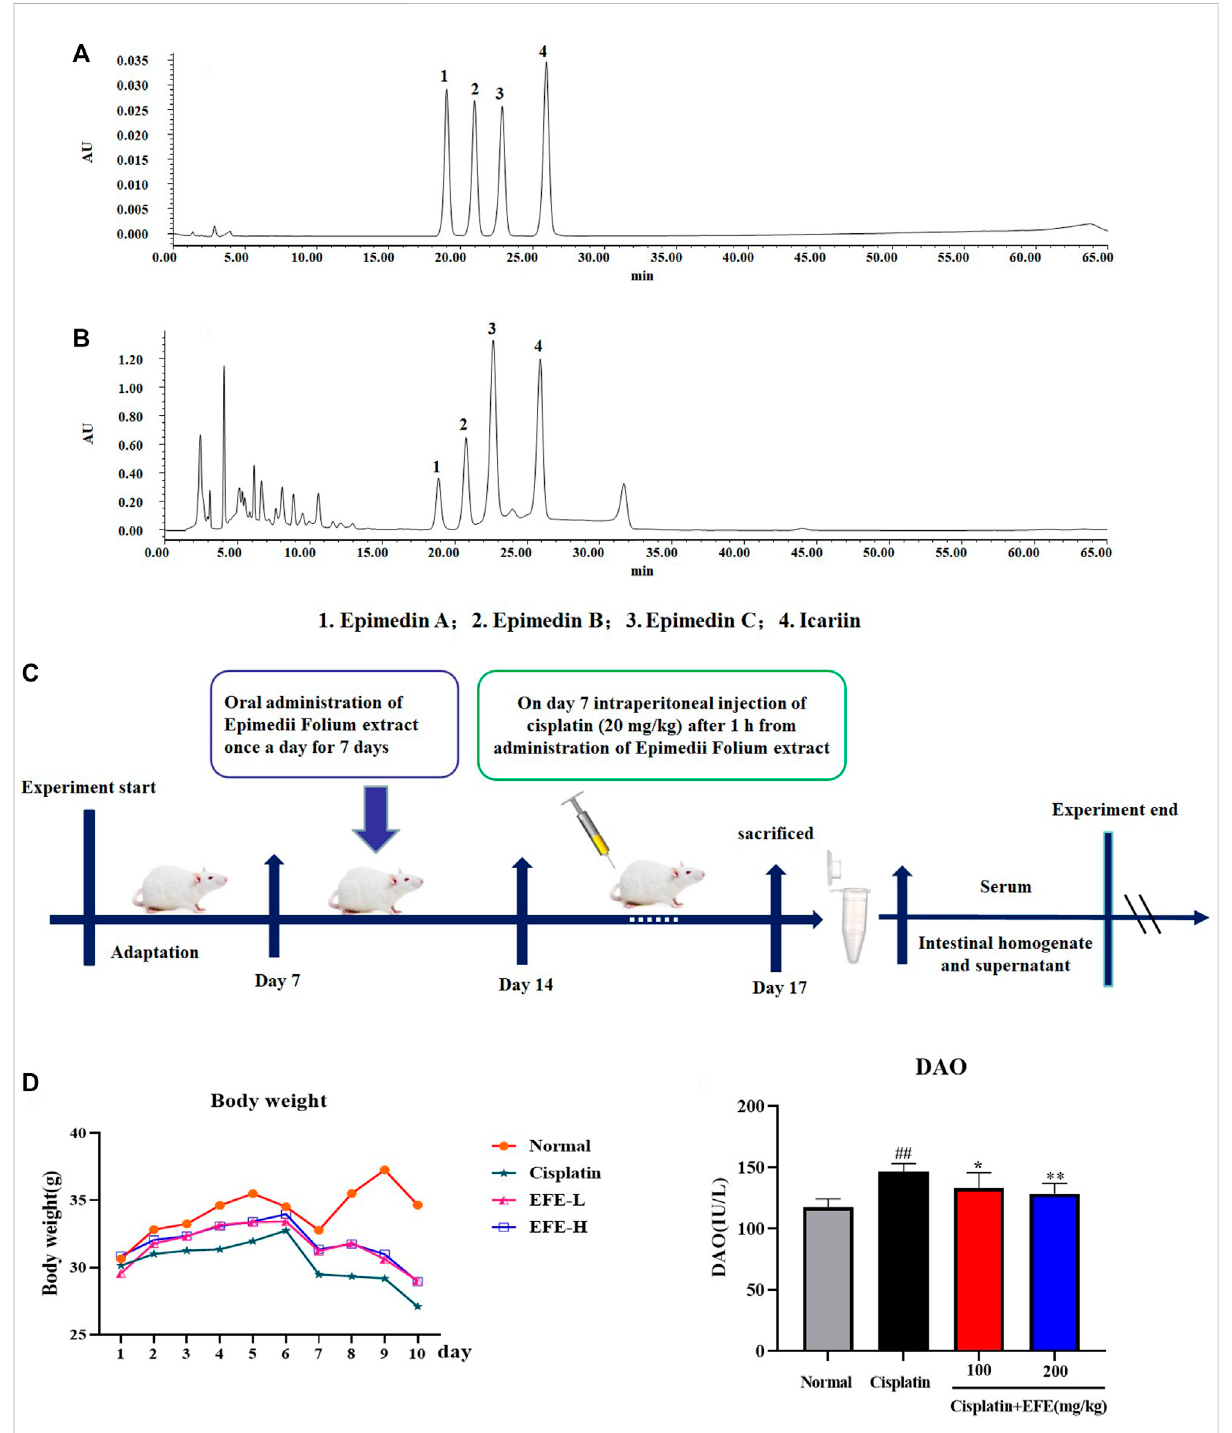
FIGURE 3 HPLC analysis of the principal components of EFE (A – B) ; Flow chart of animal experiment design (C) ; Effect of EFE on the weight change of mice with cisplatin-induced intestinal injury (D) ; Effect of EFE on DAO (E) levels in mice. Note: Values are expressed as Mean ± S.D., ( n = 10). ## p < 0.01 vs. normal group; * p < 0.05, ** p < 0.01 vs. model